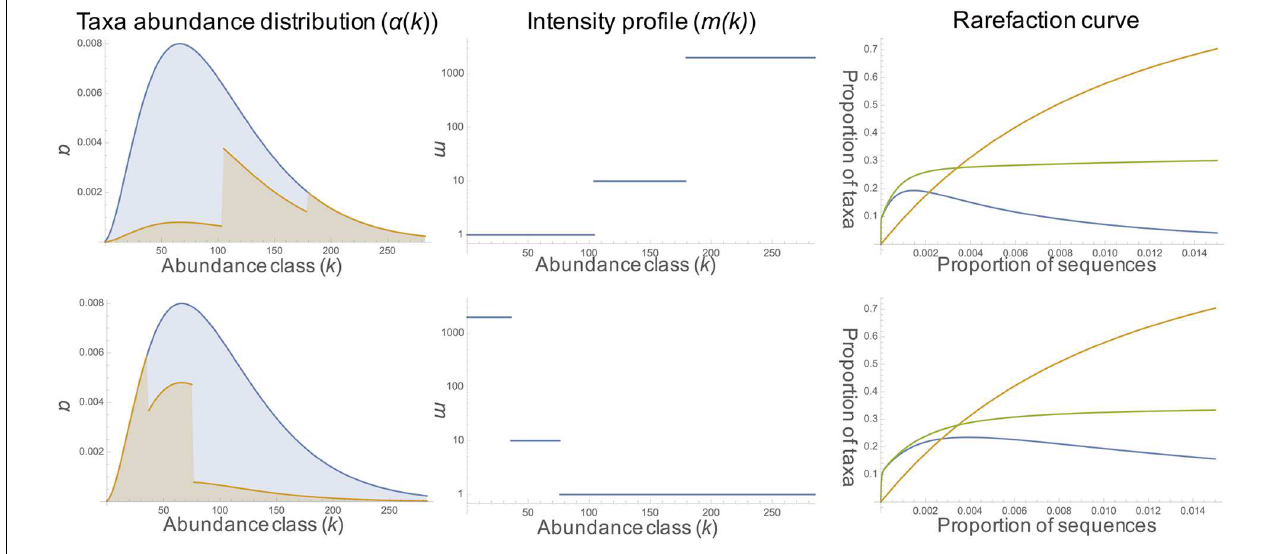
FIGURE 4 | Model results. The first column shows the rDNA taxa abundance distribution (negative binomial with shape parameter 1 in blue and the proportion of active taxa in orange [activity profile, α ( k )]. Column two shows the change in the intensity profile [i.e., rRNA: rDNA ratio, m( k )] across abundance classes. Rarefaction curves for rDNA (orange), rRNA (green), and phantoms (blue) are displayed in the third column. In row a, the proportion of active taxa increases (10%, 60%, 100%) with increasing abundance; activity intensity also increases (1, 10, 2000) with increasing abundance class. In row b, the proportion of active taxa decreases with increasing abundance (100%, 60%, 10%); activity intensity also decreases with increasing abundance (2000, 10,